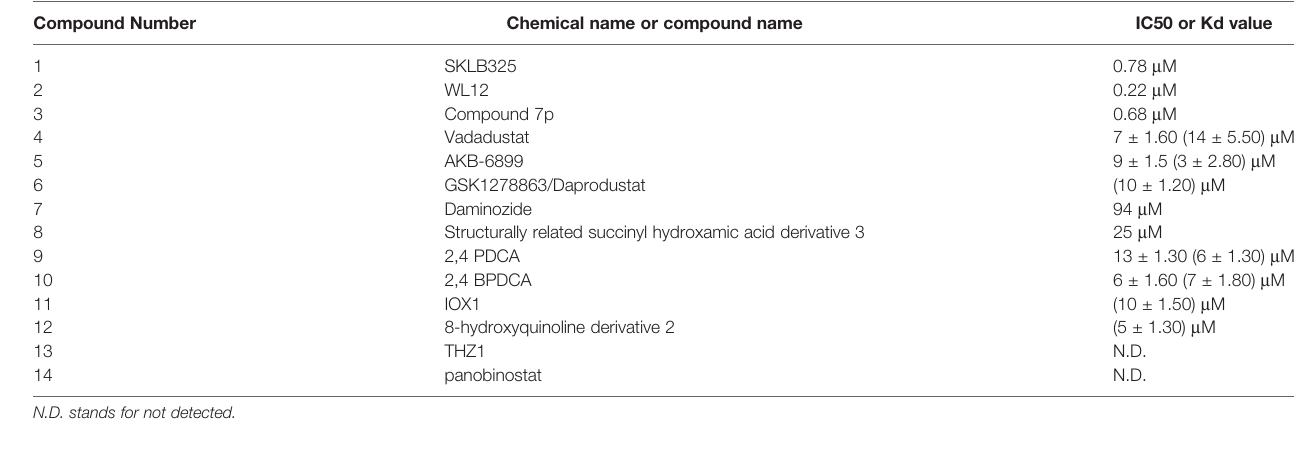
TABLE 1 | Inhibitory activities of representative JMJD6 inhibitors.